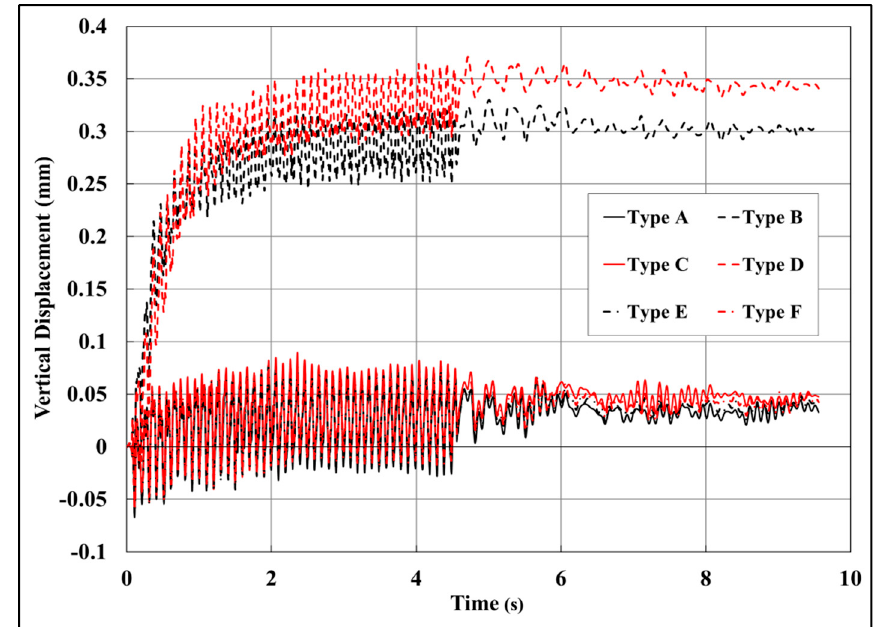
Figure 10. Vertical displacement at the bottom for each type: D-F2-B2-10 (type A), S-F1-10 (type B), D-F4-B4-5 (type C), S-F2-5 (type D), D-F4-B2-7.5 (type E), and D-F2-B4-7.5 (type F).